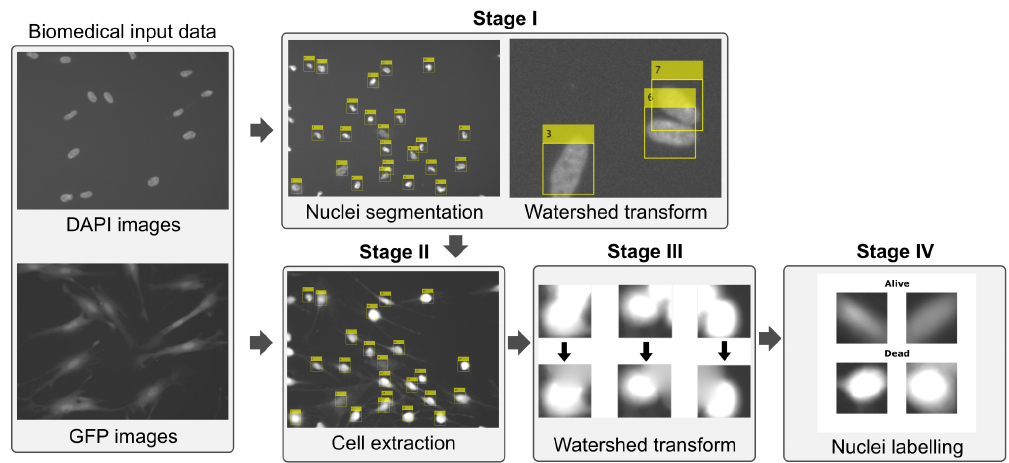
Figure 4. Flowchart of the pre-processing stage based on watershed transform (required to create individual cell patches using DAPI and GFP